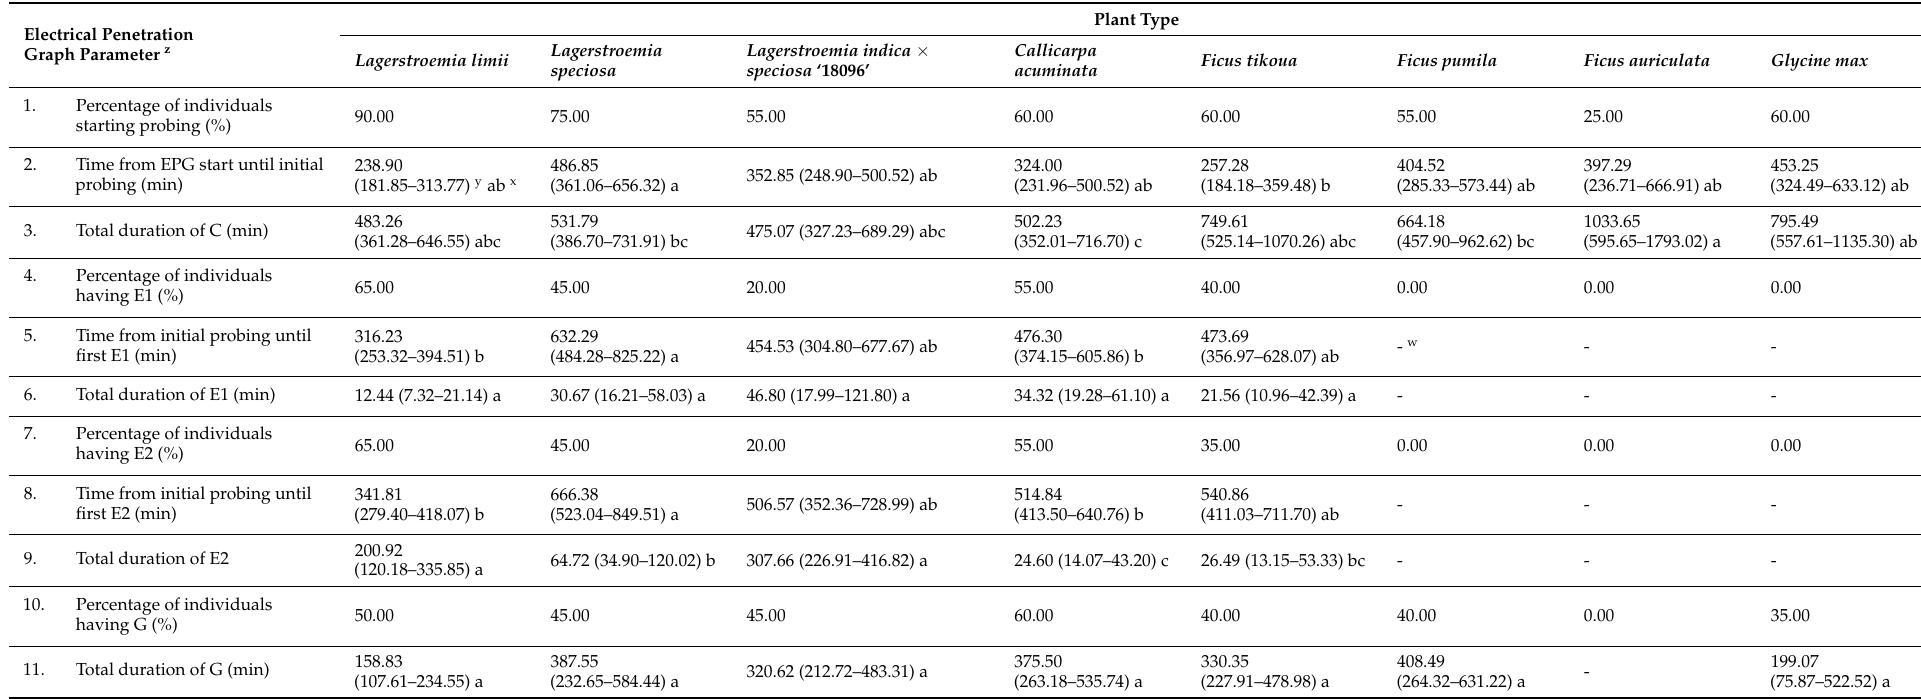
Table 4. Electrical penetration graph parameters of Acanthococcus lagerstroemiae probing on different plant